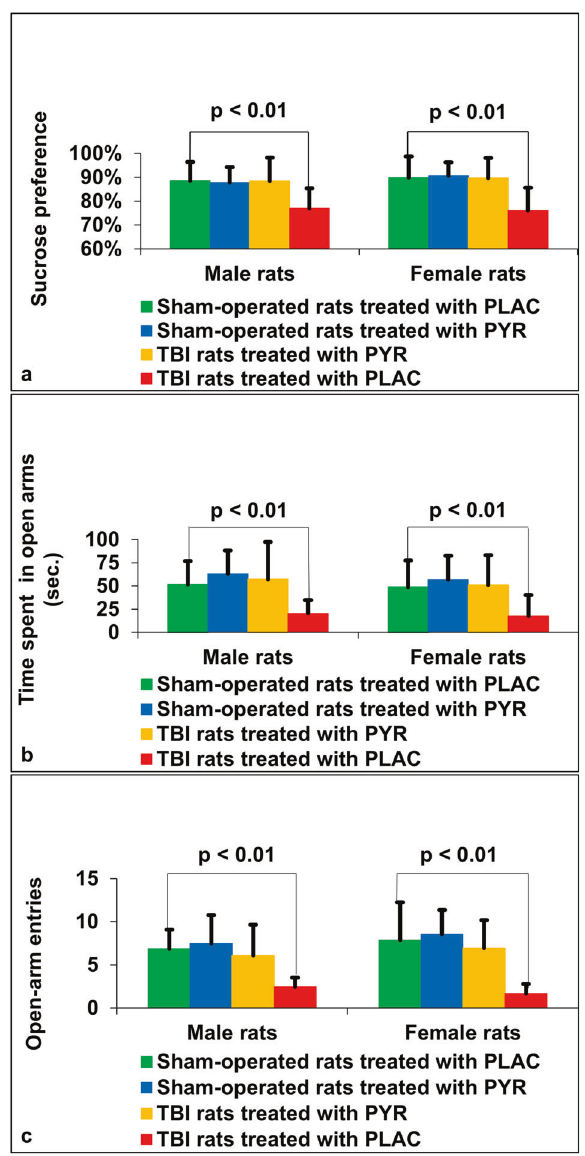
Fig. 3 The sucrose preference and elevated plus maze results. a Sucrose preference. For male rats at day 32, sham-operated rats treated with pyruvate, sham-operated rats treated with placebo and post-TBI rats treated with pyruvate had signi fi cantly higher sucrose preference compared to post-TBI rats given placebo. For female rats, there was a signi fi cant increase between sham-operated rats treated with pyruvate, sham-operated rats treated with placebo and post- TBI rats treated with pyruvate compared to post-TBI rats given placebo. b Time spent on open arms. For male and female rats, there was a signi fi cant increase in the time spent on the open arms between sham-operated rats treated with pyruvate, sham-operated rats treated with placebo and post-TBI rats treated with pyruvate compared to post-TBI rats given placebo. c Open-arm entries. For male and female rats, there was a signi fi cant increase in the open arm entries between sham-operated rats treated with pyruvate, sham-operated rats treated with placebo and post-TBI rats